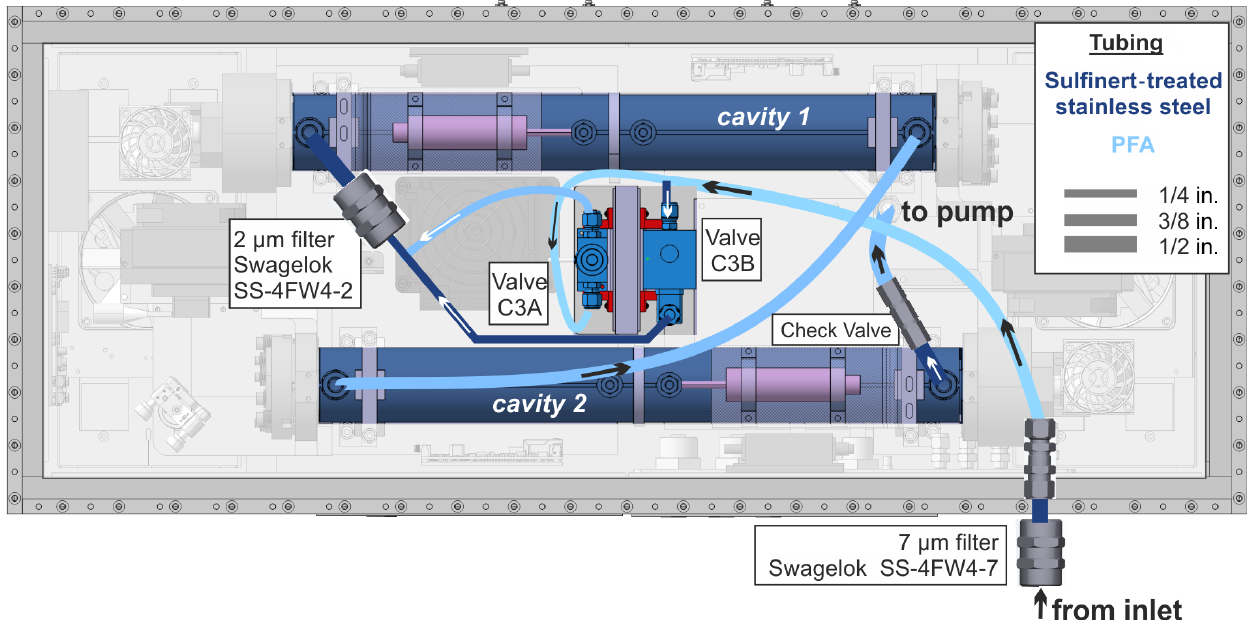
Figure 3. Sample gas flow system inside AMICA. The T-junctions where the gas flow branches off to or from the two valves C3a and C3b are marked by yellow